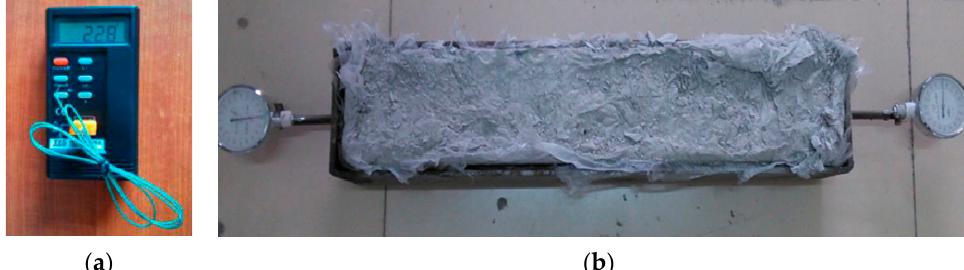
Figure 9. Instruments for the free shrinkage test: ( a ) Digital temperature tester and thermocouple; ( b ) Free shrinkage test setup.